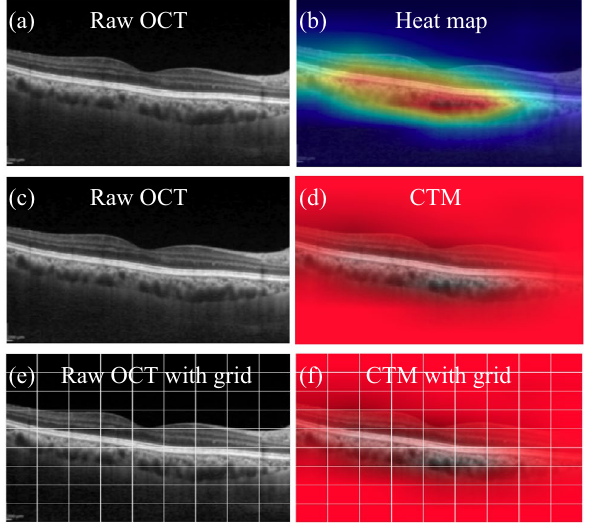
Figure 8. Visual explanations:Top row represents OCT with corresponding Grad-CAM generated heatmap; Middle row represents OCT with corresponding CTM; Last row represents OCT with corresponding CTM with grid